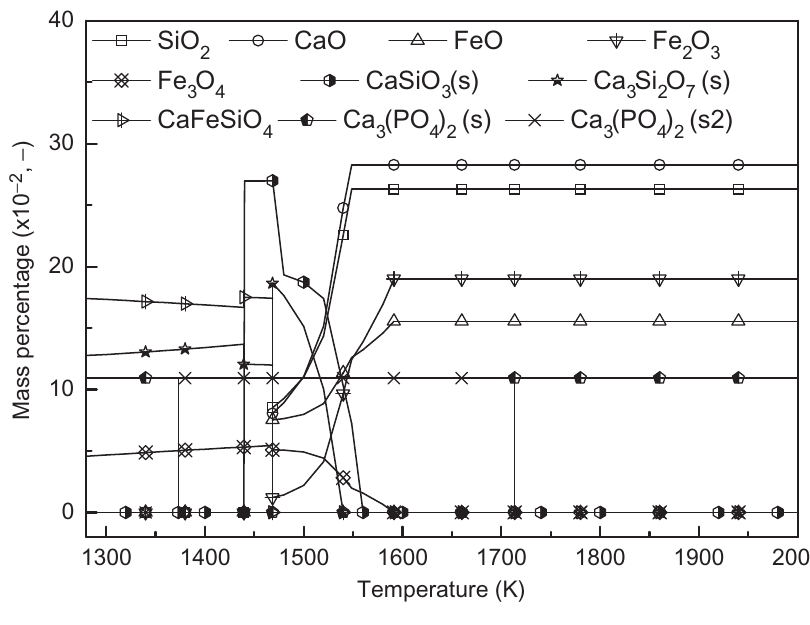
Figure 2: Variation of possibly formed components in CaO – SiO 2 – FeO – Fe 2 O 3 – P 2 O 5 steelmaking slags over a